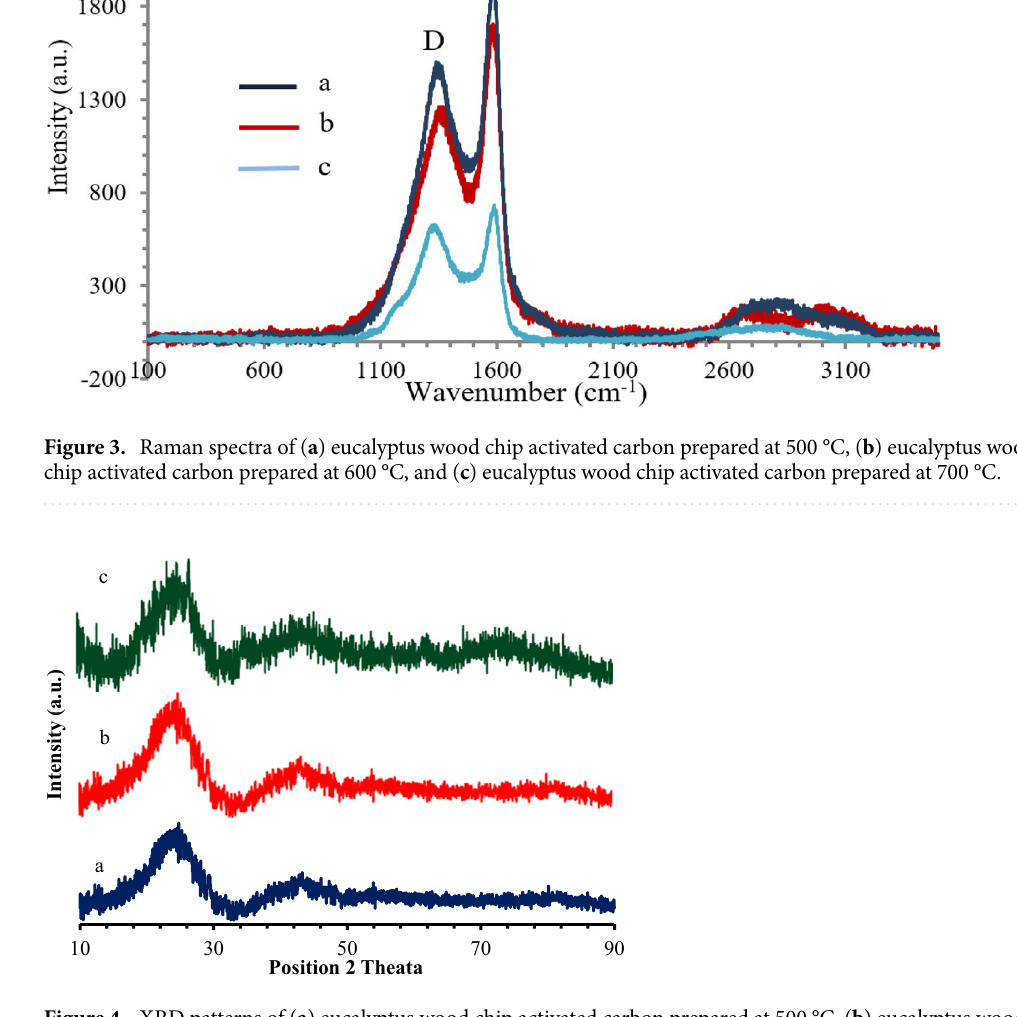
Figure 4. XRD patterns of ( a ) eucalyptus wood chip activated carbon prepared at 500 °C, ( b ) eucalyptus wood chip activated carbon prepared at 600 °C, and ( c ) eucalyptus wood chip activated carbon prepared at 700